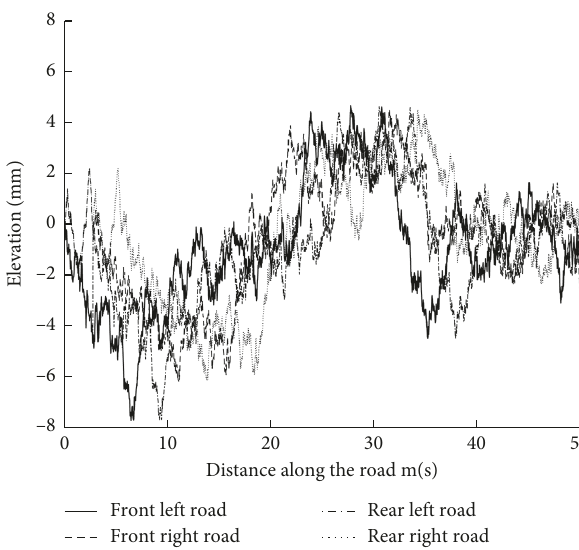
Figure 2: Class “A” road profile at each